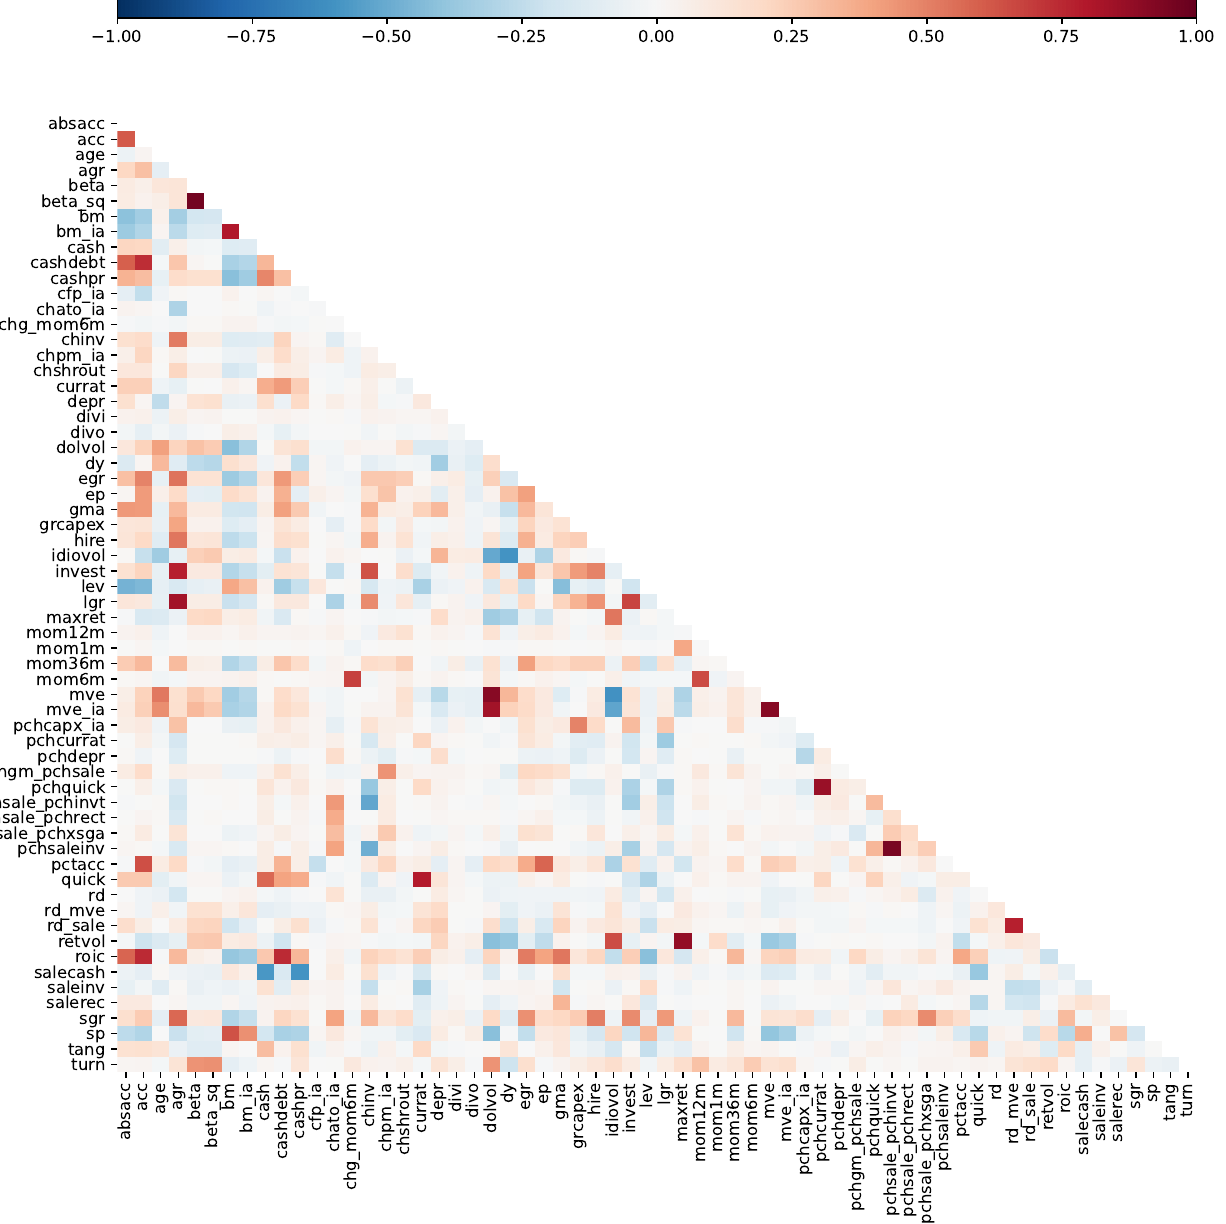
Figure 3. Empirical correlation matrix (best seen in color): The figure exhibits the correlation of all stocks and FC included in our analysis for the years June 1974 until December 2020. We use the normalized, winsorized and pooled FC data (as used in the full sample regression) to calculate the correlation coefficients. The figure shows five extreme correlation pairs (>0.9). For example, the highest absolute correlation is measured for beta and beta_sq with a coefficient slightly less than